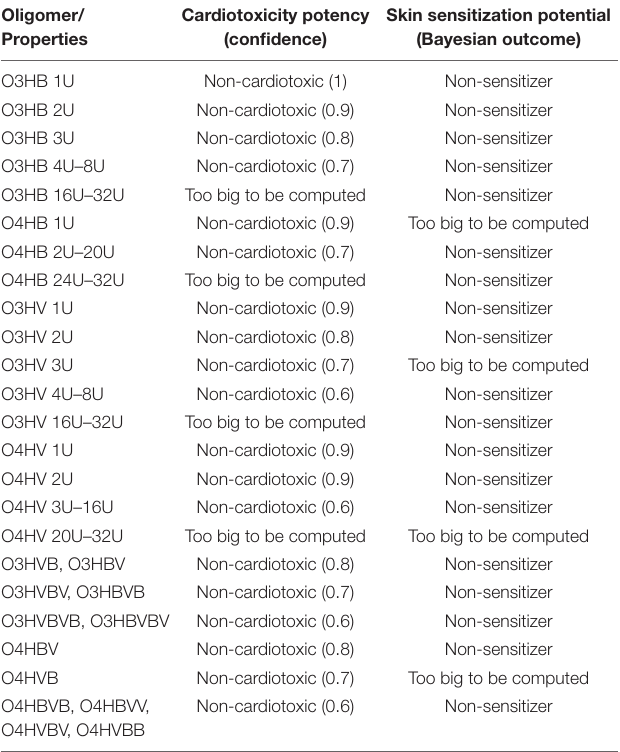
TABLE 5 | Predictions concerning cardiotoxicity obtained using Pred-hERG 4.2 computational tool and concerning skin sensitization potential obtained using the Bayesian consensus model under Pred-Skin3.0 tool for the investigated oligomers.